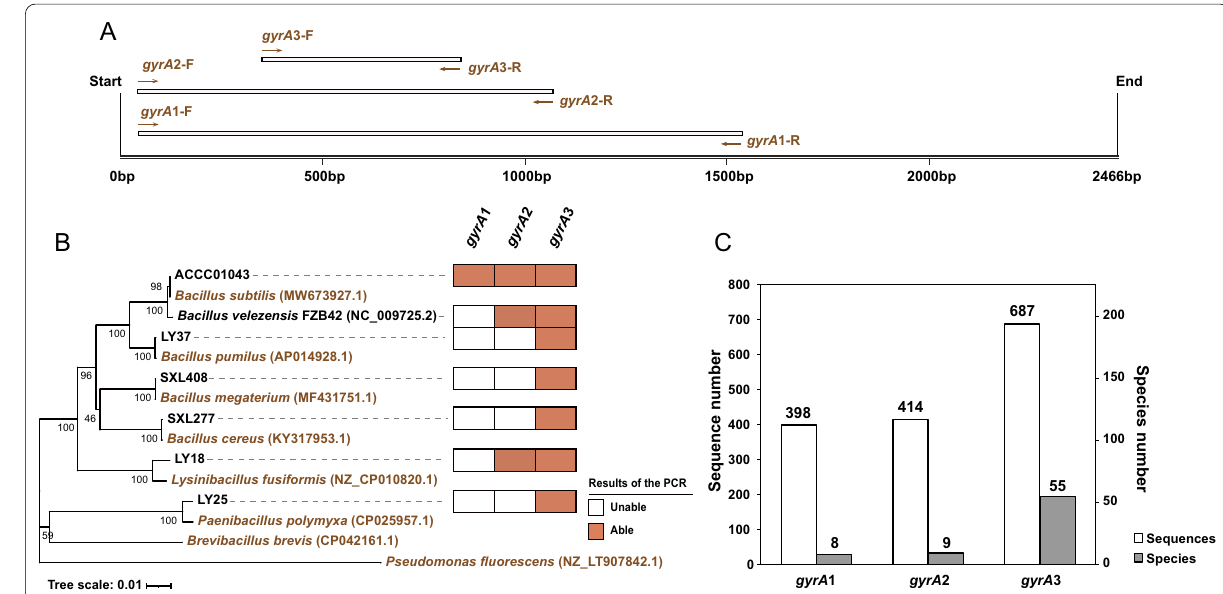
The variable sites were detected in 109 of 116 genomes (Fig. 4B), and the frequency of SNPs at the variable sites ranged from 0.4% to 6.4% (Additional file 1: Fig. S3C blue column). In B. pumilus , alignment of the 16S rRNA V3-V4 region revealed 21 variable base sites (Fig. 4C and Addi- tional file 1: Fig. S4A), but again only in 11 out of 140 genomes (Fig. 4C). The frequency of SNPs at variable sites ranged from 0.21% to 3.54% (Additional file 1: Fig. S4C red column). In contrast, in the gyrA gene, 130 of the base sites were variable (Fig. 4D and Additional file 1: Fig. S4B) and these were found in 87 of 140 genomes, with SNPs frequencies at variable sites ranging from 0.2% to 15.8% (Additional file 1: Fig. S4C blue column). How- ever, in B . pumilus nearly 50% of the genomes examined had 100% identity in the gyrA gene, indicating a high degree of relatedness between genomes that may require sequencing of additional marker genes for clonality veri- fication and strain